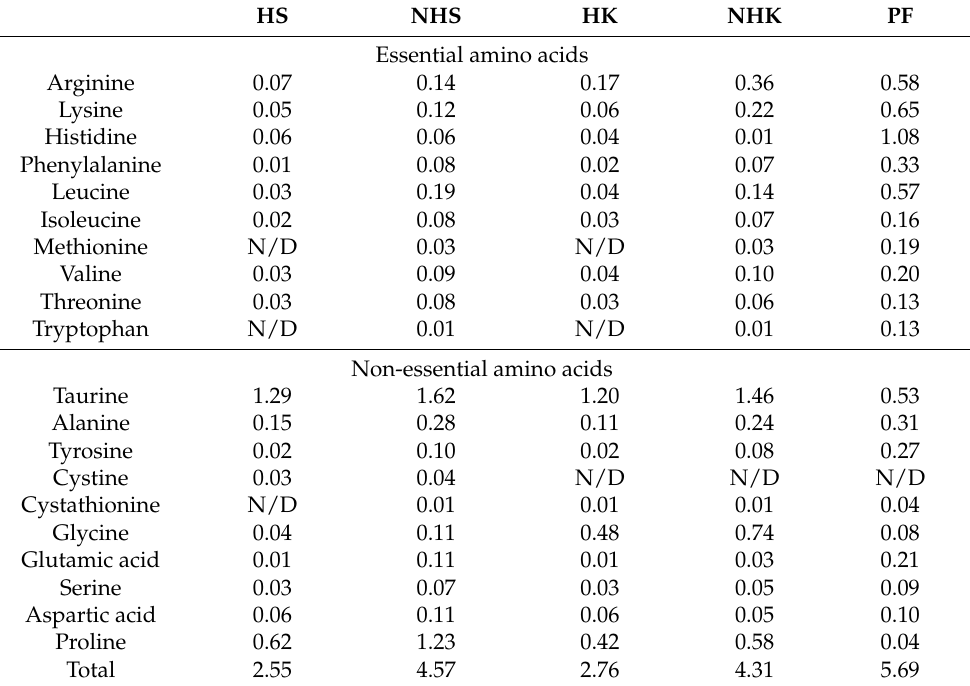
Values are presented as means of triplication. HS, heated squid meal; NHS, non-heated squid meal; HK, heated krill meal; NHK, non-heated krill meal; PF, prey fish; Spangled emperor larvae, Lethrinus nebulosus . N/D: not detected (detection limit: 0.01 g/100 g, dry-weight). Table 3. Free amino acid content of the test diets (g/100 g,